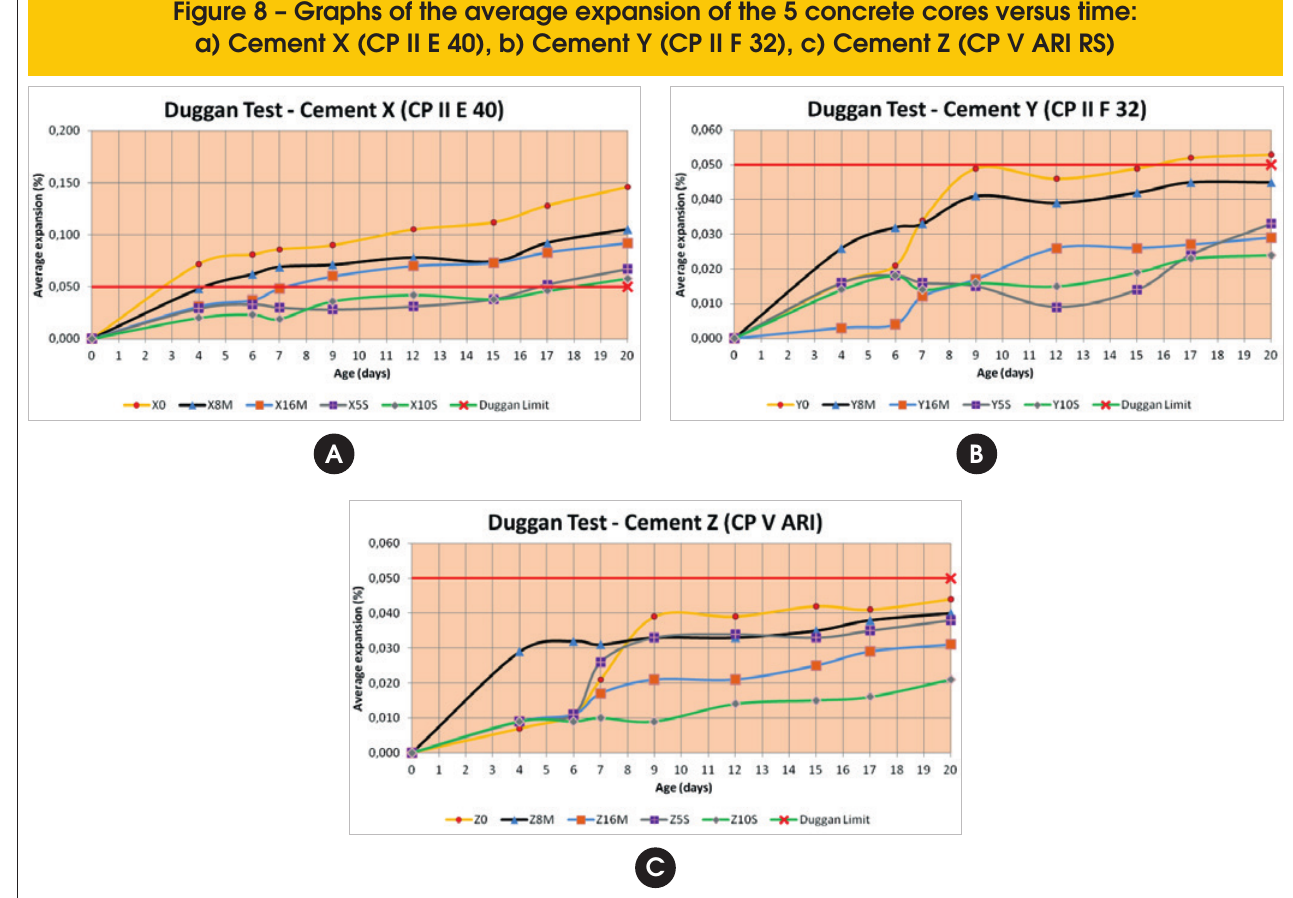
Figure 8 – Graphs of the average expansion of the 5 concrete cores versus